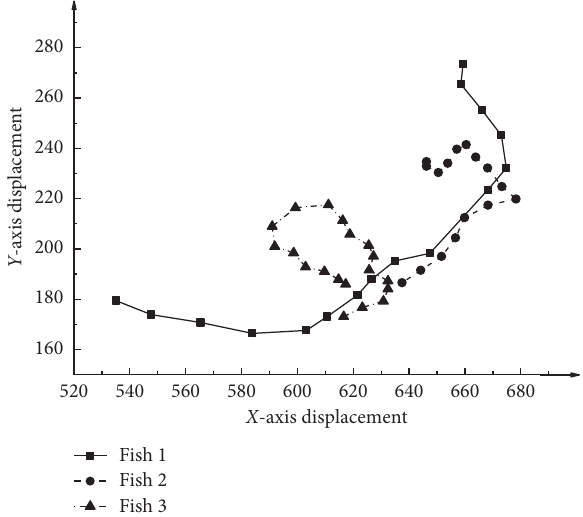
Figure 5: Moving trajectory of medaka’s swimming motion.